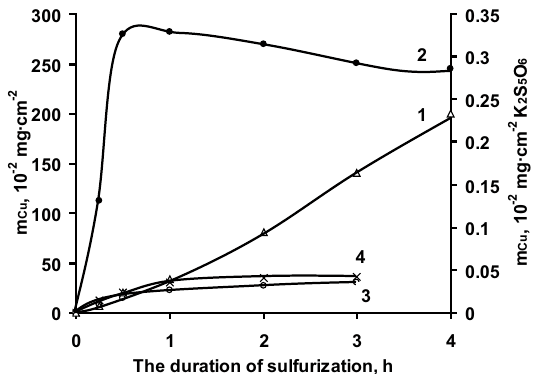
Figure 2. Changes of amount of copper in Cu